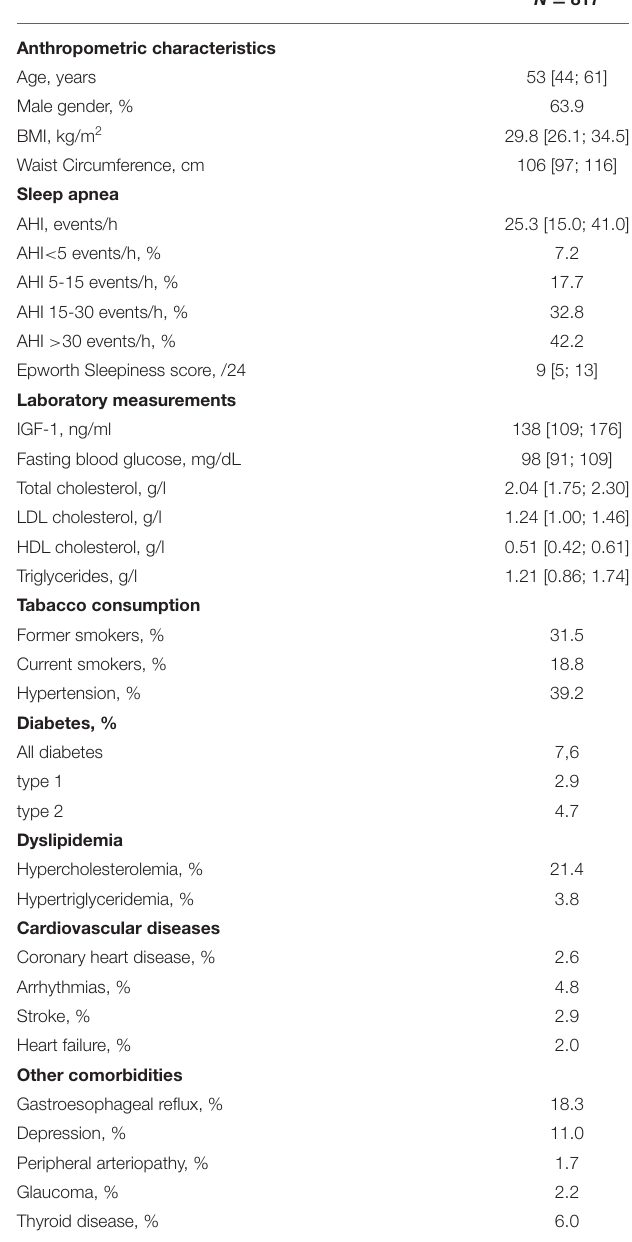
TABLE 1 | Characteristics of